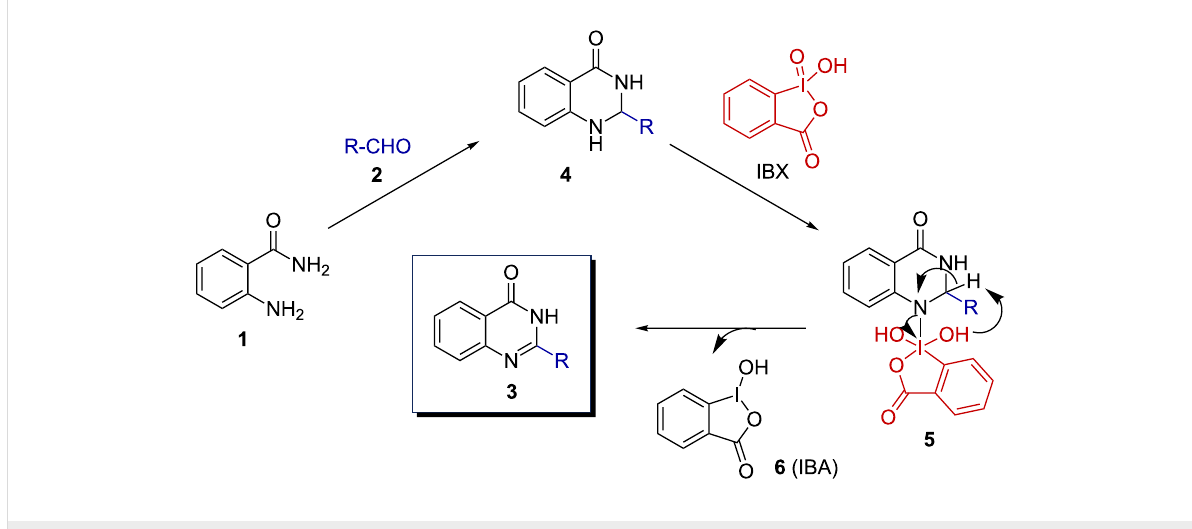
Figure 6: Plausible mechanism for the quinazolin-4(3 H )-ones synthesis using IBX.